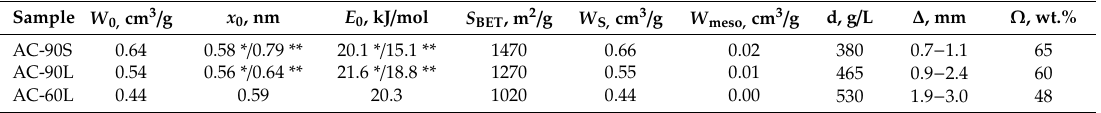
Table 1. The parameters of the porous structure of the coconut shell (CNS)-derived AC adsorbents with the various burn-o ff degree, packing density, and globular sizes evaluated from adsorption data by the Dubinin–Radushkevich (D–R), Brunauer–Emmet–Teller (BET), and Kelvin equations.